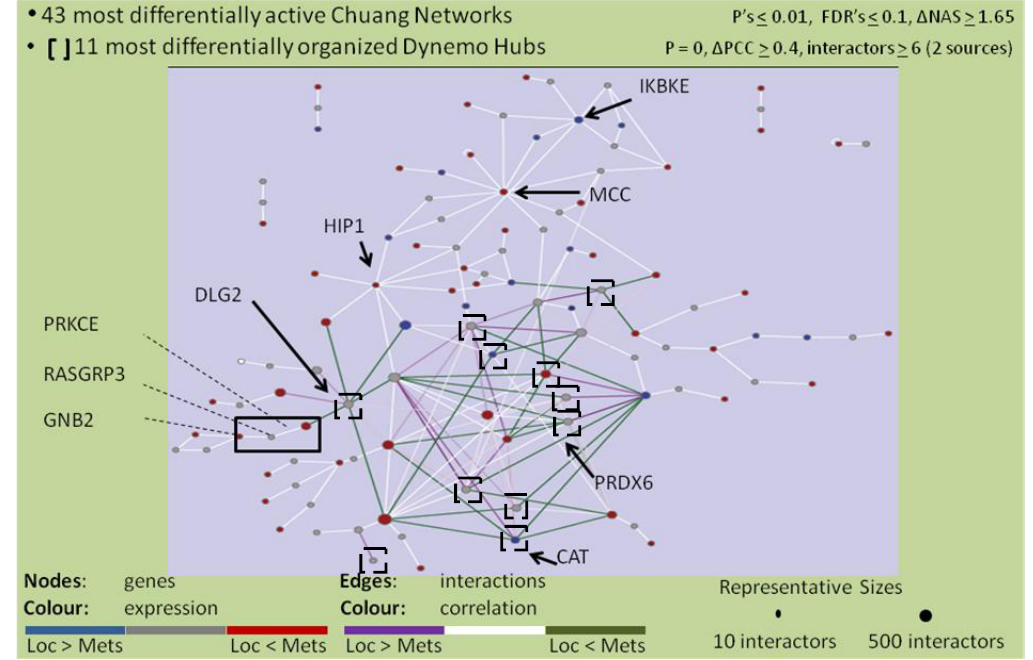
Figure 4. Genes comprising 43 differentially activated networks that meet stringent cut-offs (detailed at the top of the figure) were visualized with Cytoscape, as well as their interactions with 11 differentially organized networks (that also met stringent cut-offs which are detailed at the top of the figure). Coloured nodes represent relative abundance in metastatic samples vs . localized samples (red = more abundant, blue = less abundant). Coloured edges represent correlations between genes in metastatic samples vs . localized samples (green = more correlated, purple = less correlated).The number of included interactors of each gene in this study is proportional to the size of the node depicting the